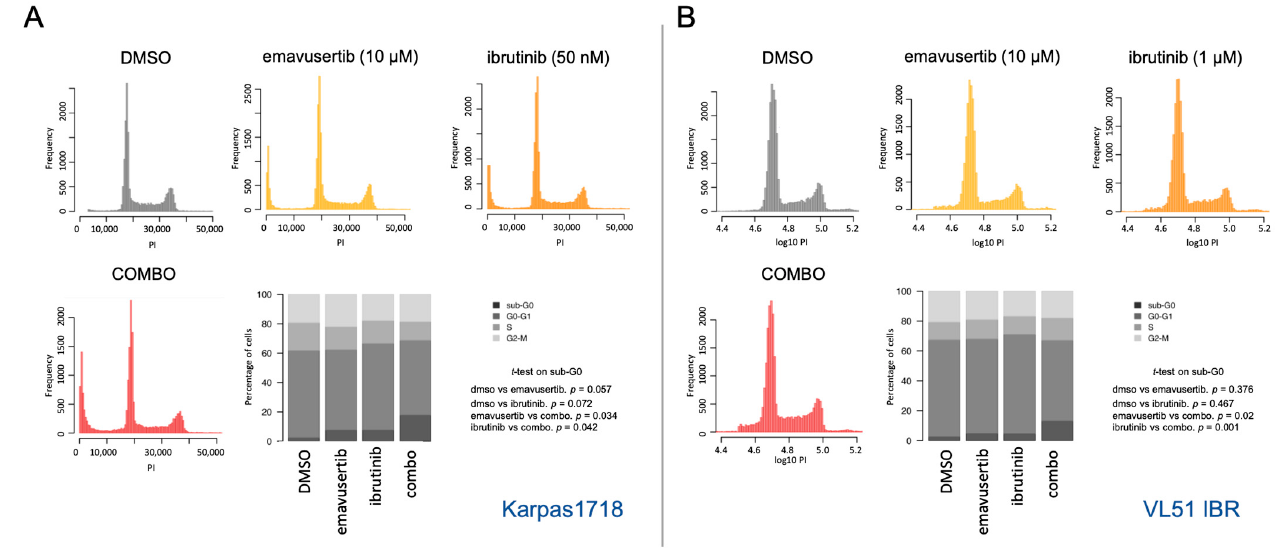
Figure 6. Emavusertib in combination with ibrutinib increases sub G0-G1 population. Representative histograms and cell-cycle distribution upon emavusertib (10 µ M) alone or in combination with ibrutinib (72 h) in ( A ) K1718 parental and ( B ) VL51 ibrutinib resistant cell line. Ibrutinib doses were selected based on the IC50 values in the parental lines (50 nM in K1718, 1 µ M in VL51). Data represent the average of two independent experiments. p for nominal p -value from t-test.